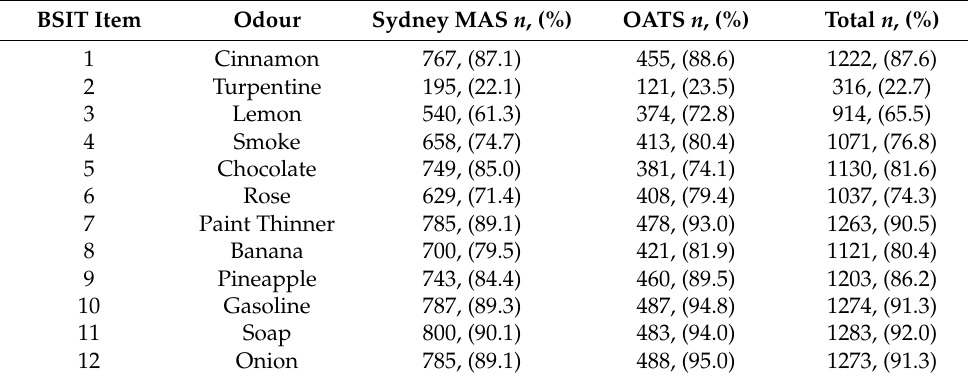
Table 2. Number and percentage of correct responses for individual BSIT items for Sydney MAS, OATS and total